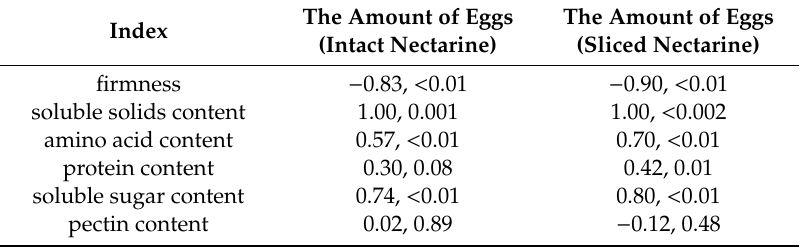
The data indicate Pearson correlation coe ffi cient and p